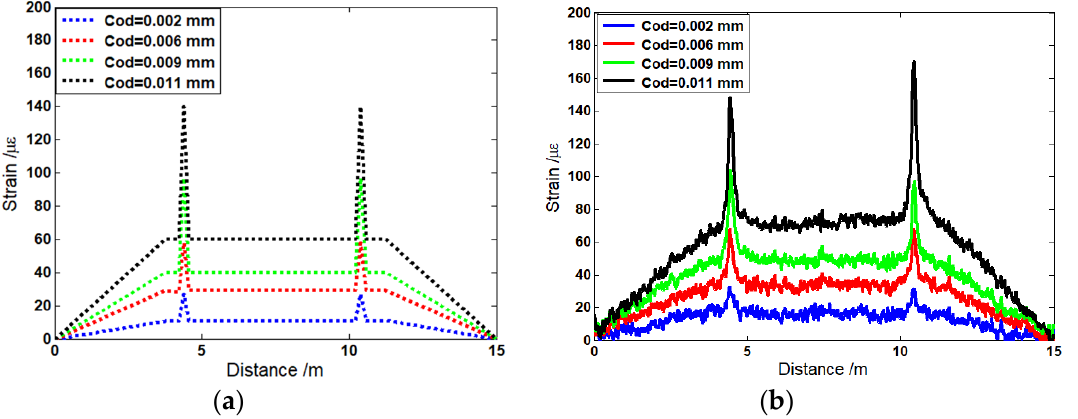
Figure 4. Strain curves with ( a ) theoretical and ( b ) experimental results for COD = 0.002 mm, 0.006 mm, 0.009 mm, and 0.011 mm.